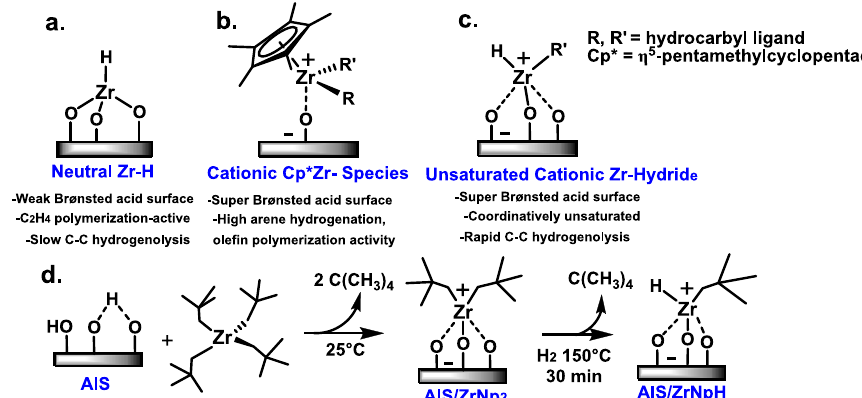
Fig. 1 | Schematic depiction of zirconium alkyl surface chemistry on various oxide surfaces. a Zr alkyl-derived adsorbate on a relatively weak Brønsted acidic surface, providing relatively strong conjugate Brønsted base counteranions, b Cp*Zr(CH 3 ) 3 -derived adsorbate on a very strong Brønsted acidic surface (AlS=